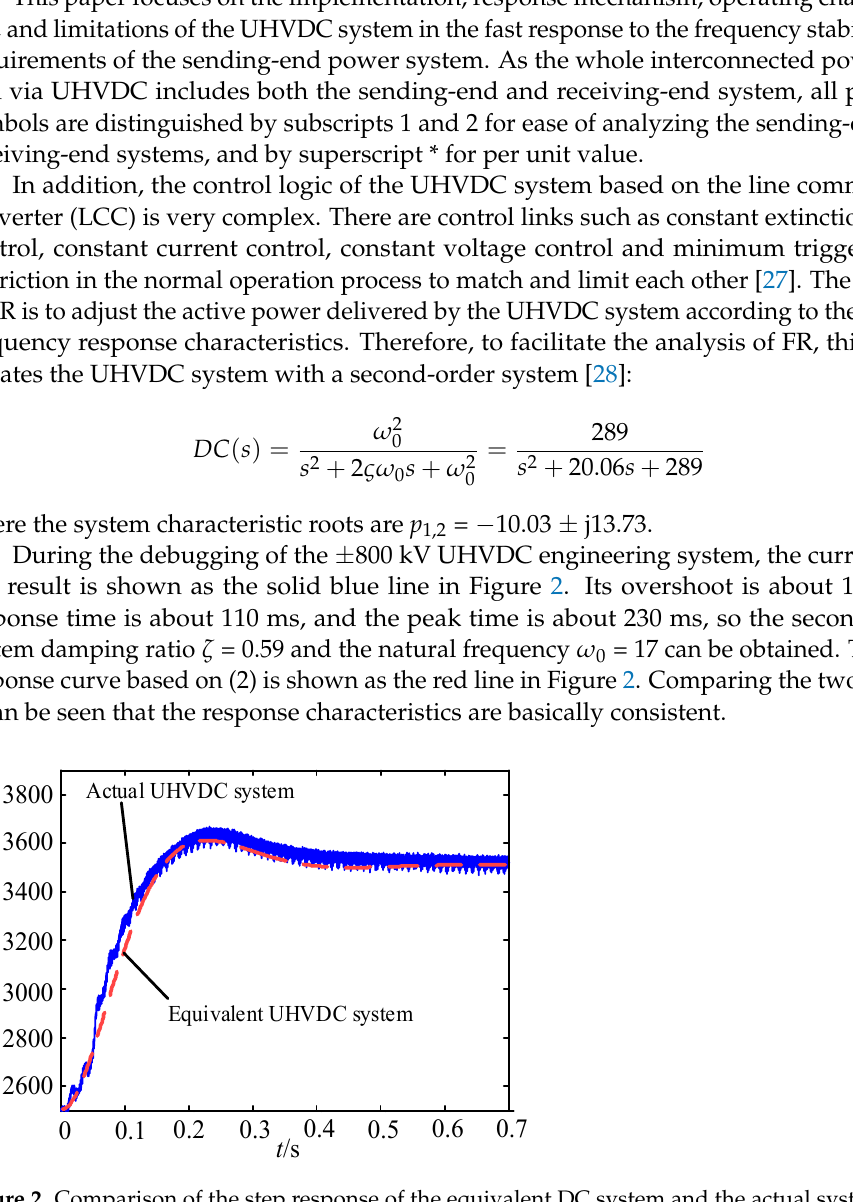
Figure 2. Comparison of the step response of the equivalent DC system and the actual system.